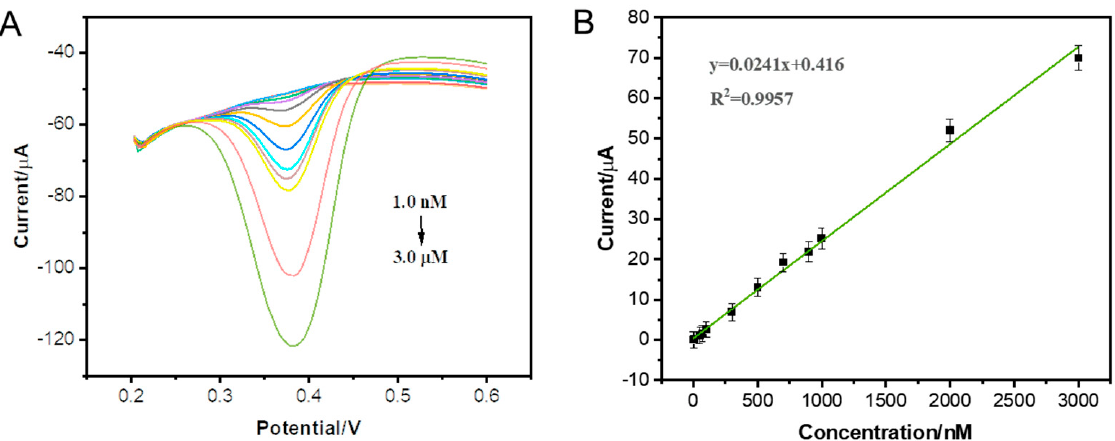
Figure 3. ( A ) DPV pattern of CAU − 1/MWCNT/GCE at different rutin concentrations. ( B ) Working curve of CAU − 1/MWCNT/GCE for rutin detection. To evaluate the performance of the present sensor, some reported sensors for rutin are and a lower detection limit; therefore, CAU − 1/MWCNT/GCE has excellent detection performance for rutin. Table 1. Some previous work of electrochemical sensors for rutin .